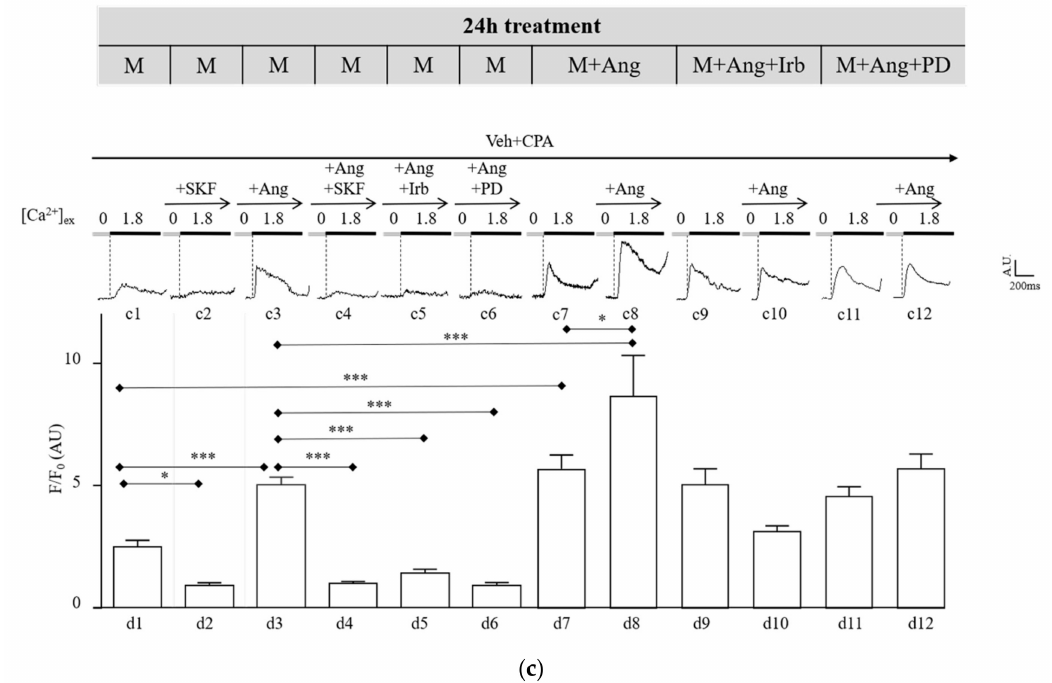
Figure 5. Functional coupling between Ang and TRPC channels on hSCs: ( a ) mRNA expression of TRPC1–7 channels in hSCs at passage 3; ( b ) immunolabelling of TRPC1, 3, 4, 6 channels in hSCs. Channel proteins are stained in red, and nuclei are in blue (DAPI). All image magnifications are 20X; ( c ) experimental scheme (top) used for 24 h conditioning of hSCs prior to fluorescence calcium imaging. Culture conditions were: M supplemented with 100 nM Ang (M + Ang), 100 nM Ang plus 1 µ M irbesartan (M + Ang + Irb), or 100 nM Ang plus 100 nM PD123319 (M + Ang + PD). The experimental protocol to perform fluorescence calcium imaging used a vehicle solution (Veh) supplemented with 5 µ M cyclopentyladenosine (Veh + CPA) and 0 or 1.8 mM CaCl 2 to stimulate a transient intracellular Ca 2 + entry (trace c1). The histogram (bottom) shows mean peak values ( ± standard error) of Ca 2 + transients measured in cells cultured in the M for 24 h (column d1), exposed to acute 5 µ M SKF (d2, trace c2,), 100 nM Ang (d3, trace c3,), Ang plus SKF (d4, trace c4), Ang plus Irb (d5, trace c5), and Ang plus PD (d6, trace c6). Ca 2 + transients measured in cells conditioned for 24 h in M + Ang (top scheme) are represented by trace c7 and column d7, and by trace c8 and column d8 after acute stimulation by 100 nM Ang. Similar measurements were performed in: cells conditioned for 24 h in M + Ang + Irb (top scheme) without / with acute stimulation by Ang (trace c9, column d9 / trace c10, column d10); cells conditioned for 24 h in M + Ang + PD (top scheme) without / with acute stimulation by Ang (trace c11, column d11 / trace c12, column d12). * p < 0.05, *** p <